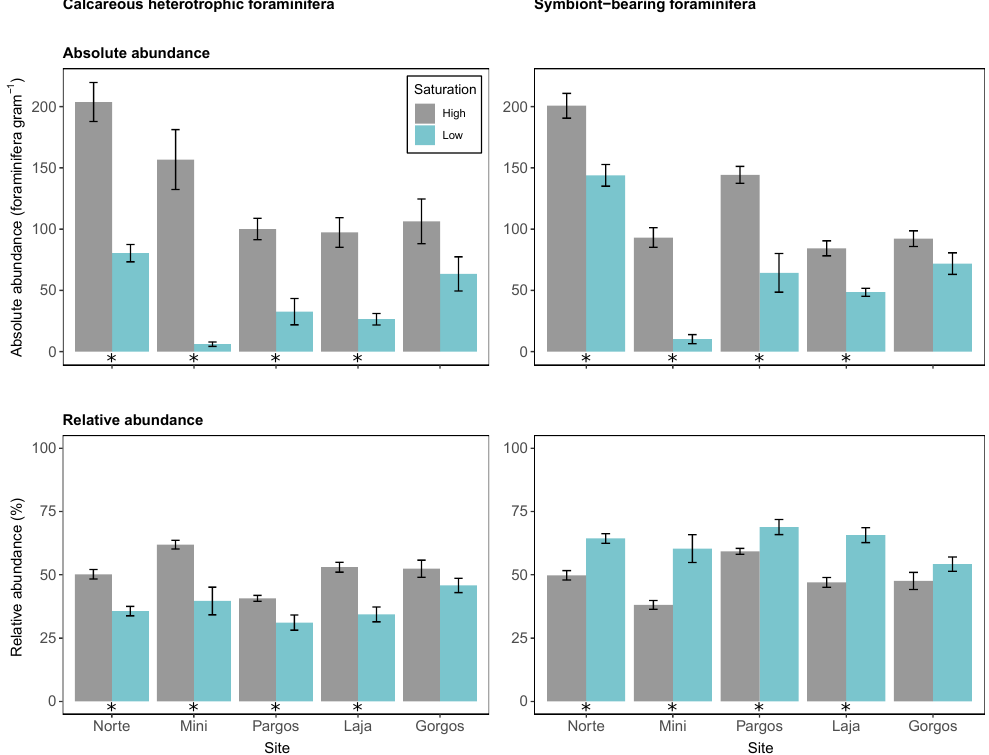
Figure 6. Absolute abundance (specimens per gram of sediment) and relative abundance (percentage) of different feeding strategies of calcareous foraminifera (symbiont-barren heterotrophic and symbiont-bearing). Data are represented in mean ± SE ( n = 5). The asterisk demarks a significant difference ( p< 0 . 05) in abundance between paired springs and controls at each site, according to Mann–Whitney rank sum